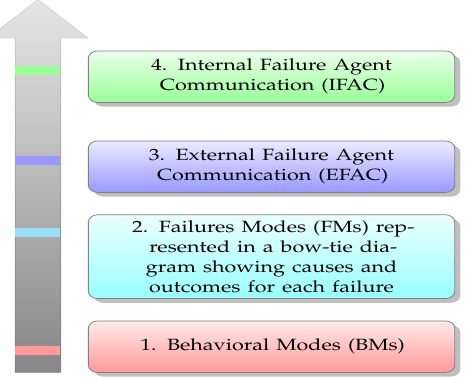
Figure 4. Proposed features to be added for the classical agent model.